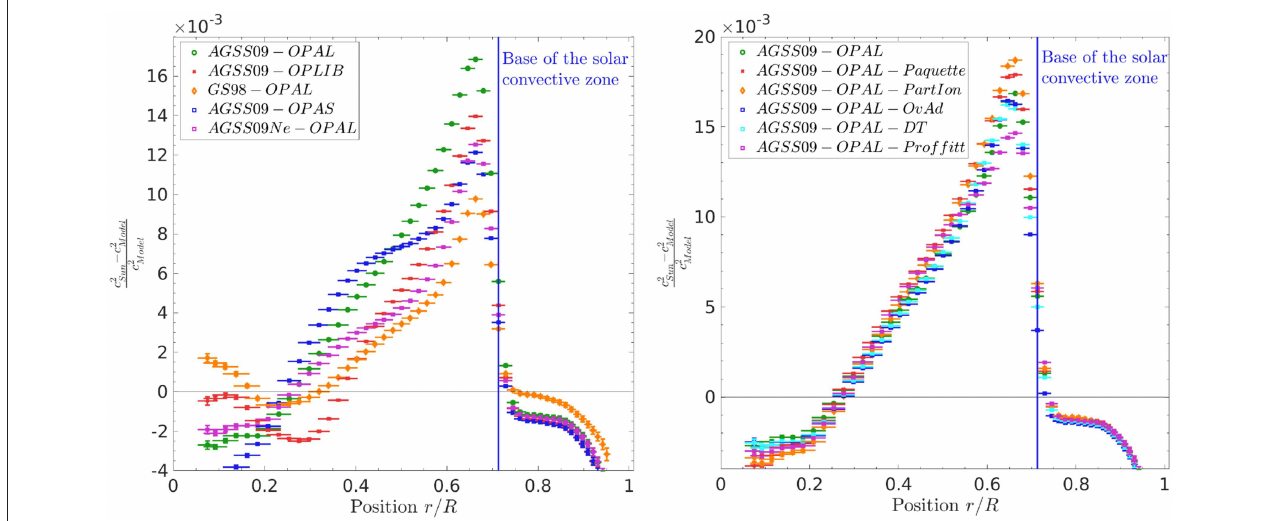
FIGURE 2 | (Left) Relative squared sound speed differences between standard solar models using various abundance and opacity tables and helioseismic results. (Right) Relative squared sound speed differences between models including various prescriptions for the mixing of the chemical elements and helioseismic